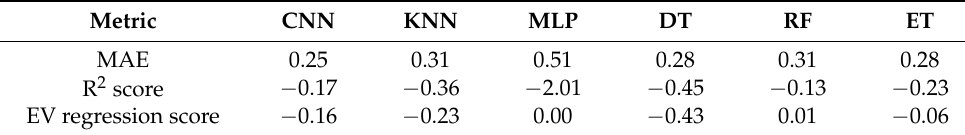
Table 11. Evaluation metrics for validation set on whole information dataset.